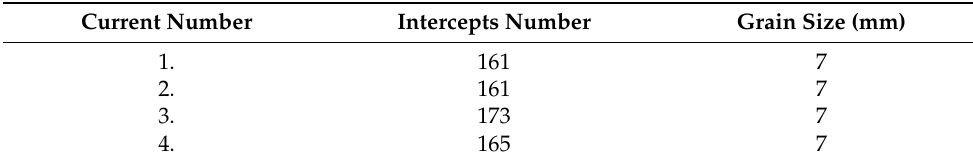
Table 11. The results were obtained after determining the austenitic grain index for the 42CrMo4 sample